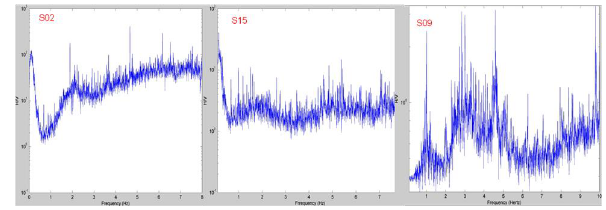
Figure 4. The H/V spectral ratio at stations S02, S09 and S15. 2 Fig. 4. The H/V spectral ratio at stations S02, S09 and